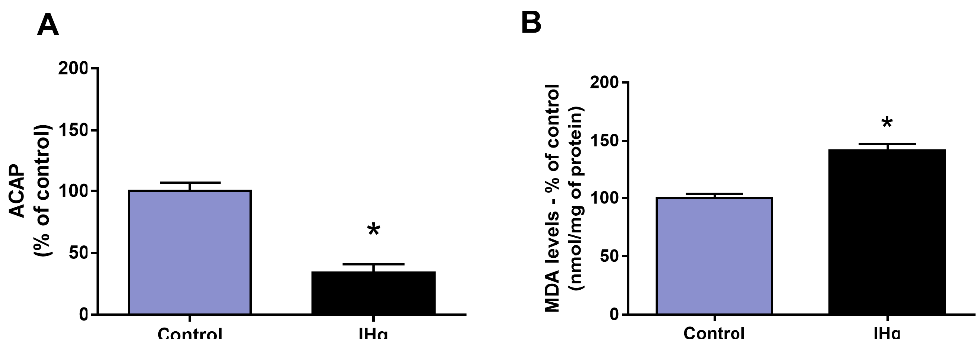
Figure 3. Oxidative biochemistry analyses of adult rats’ cerebellum exposed to 0.375 mg/kg of HgCl 2 for 45 days. In ( A ) analyses of Antioxidant Capacity Against Peroxyl Radicals (ACAPs) and ( B ) lipid peroxidation (LPO). Data presented as percentage (%) of control (mean ± S.E.M.). * p < 0.05, t -Student test (n = 10).